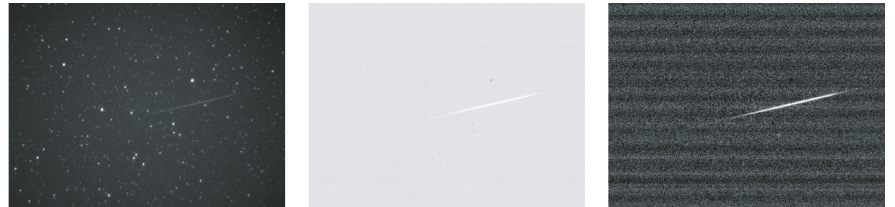
Figure 4: Di ff erential imaging method applied to a meteor track. Left pane: original frame imaged by the FAVOR camera. Middle pane: image with the “average frame” (the mean values of each pixel over the last 100 frames), subtracted. There are residual signatures of stars due to higher level of fluctuations in the wings of star PSFs, as well as regions with very low fluctuation levels due to CCD defects and dust in the focal plane. Right pane: residual image divided by a “dispersion frame” (standard deviations for each pixels estimated over last 100 frames). The only significant deviations from the zero level are due to the fast transient, which may be located and extracted by a thresholding on a 3-4 σ